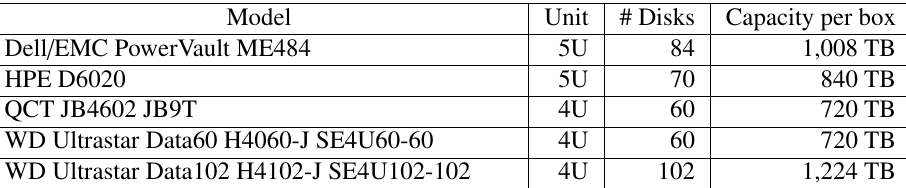
Table 1: List of selected high density JBOD products. These models are not equipped with hardware-level RAID controllers.